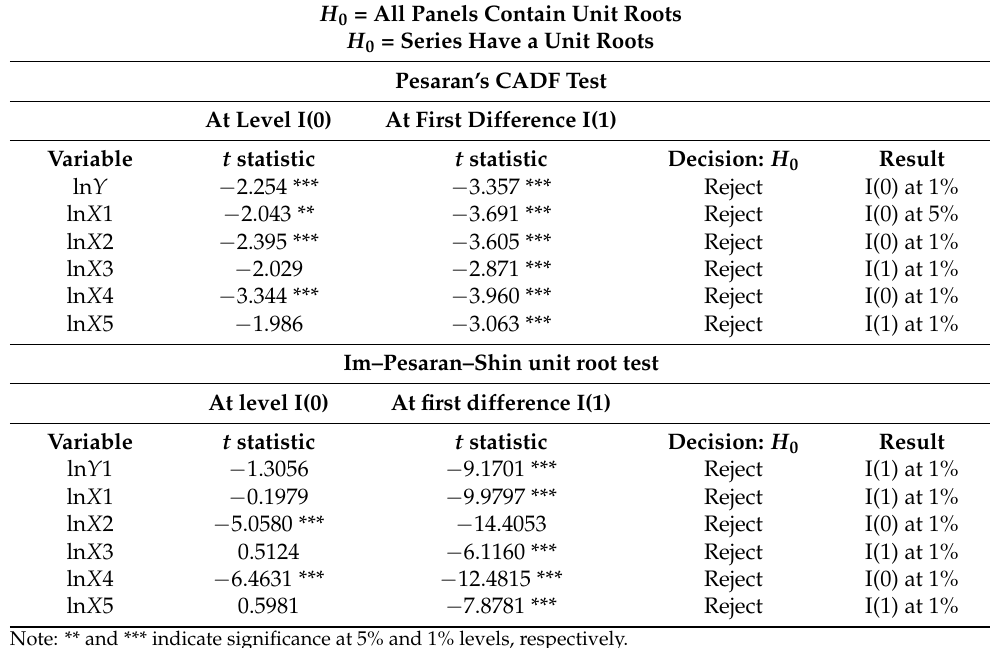
Table 7. Unit root test.